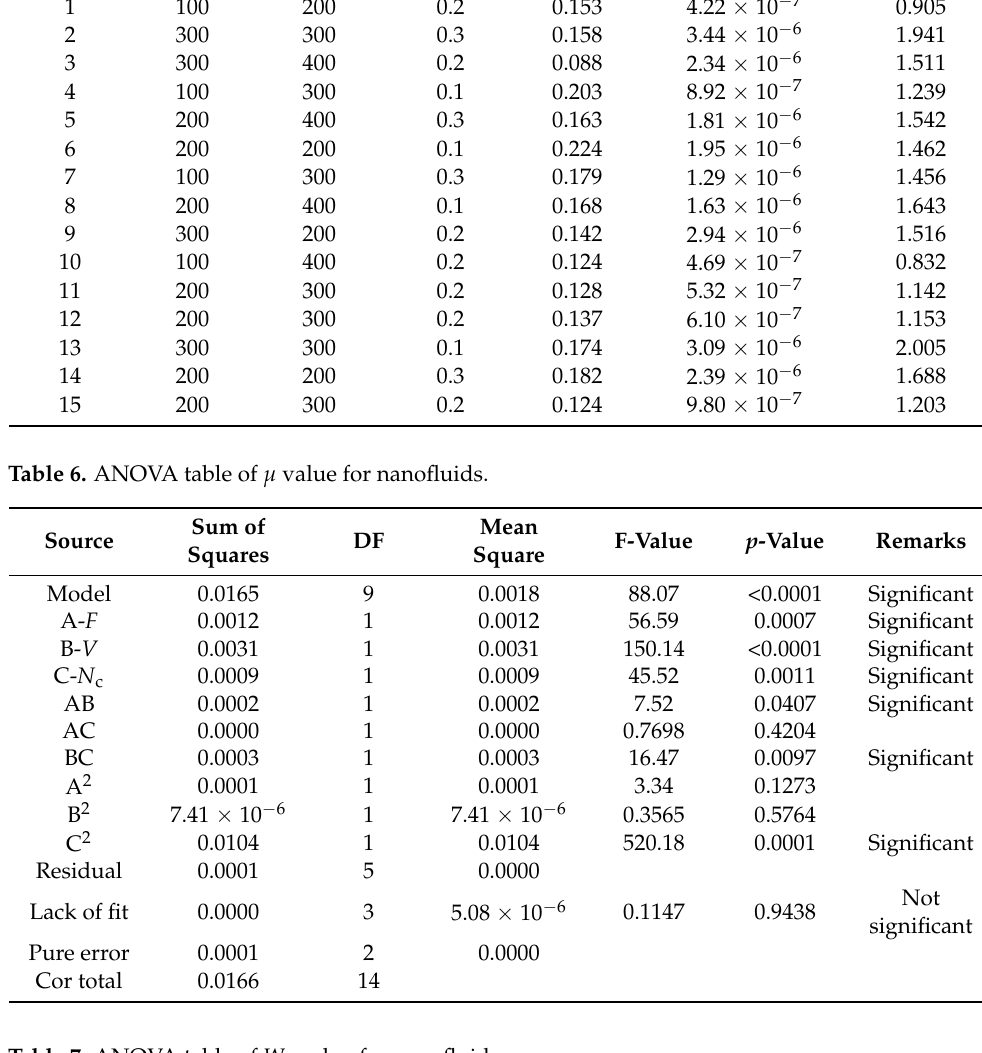
Table 7. ANOVA table of W r value for